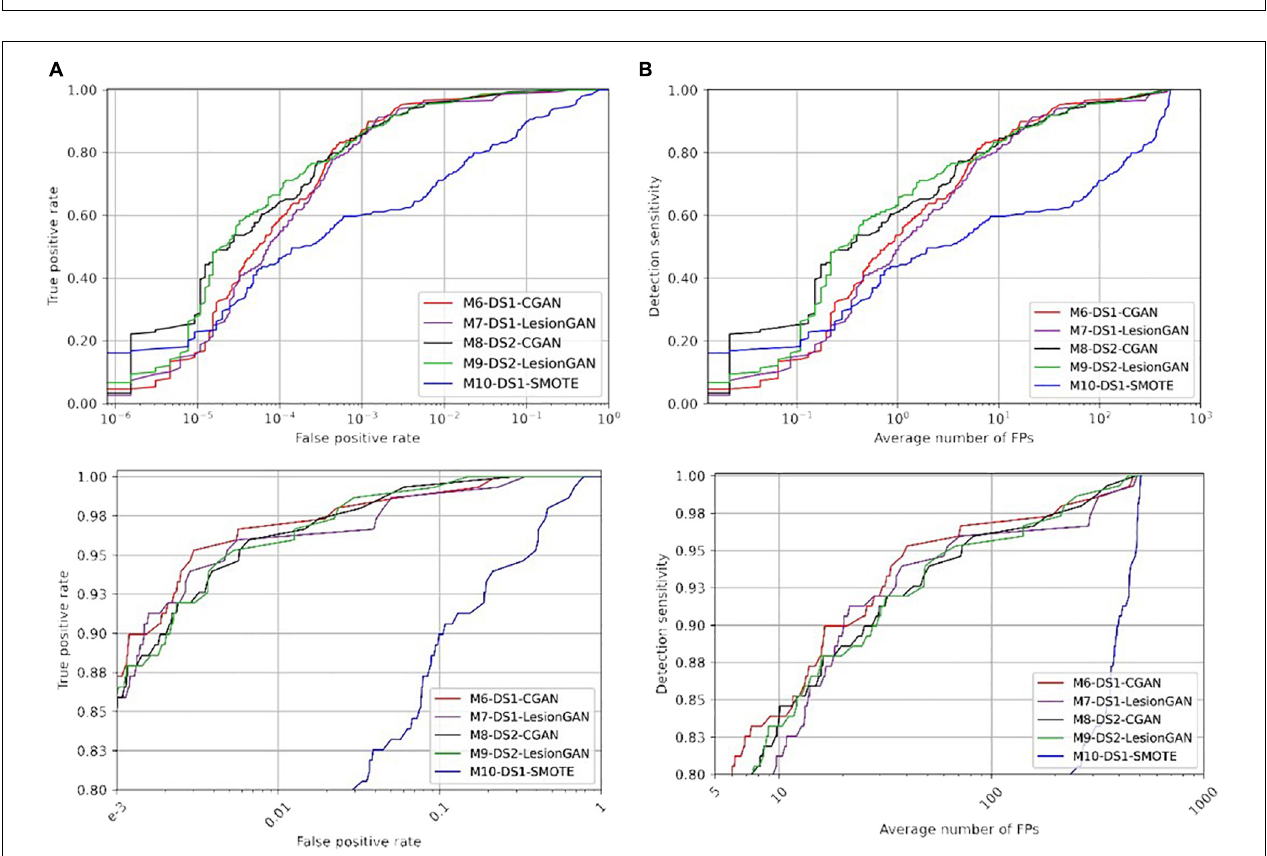
FIGURE 9 | Receiver operating characteristic (ROC) (A) and free-response ROC (B) curves for cerebral microbleed classification on the whole unseen MRI image (DS2). The bottom panel shows the zoomed version.